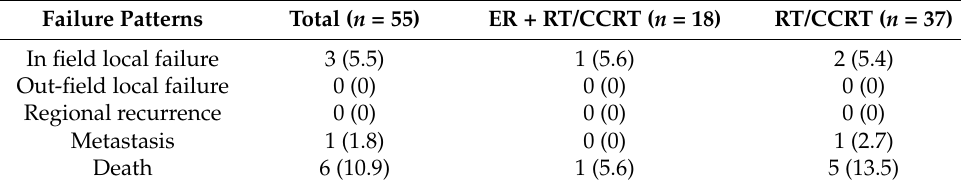
Table 3. The failure patterns [ n (%)] † .